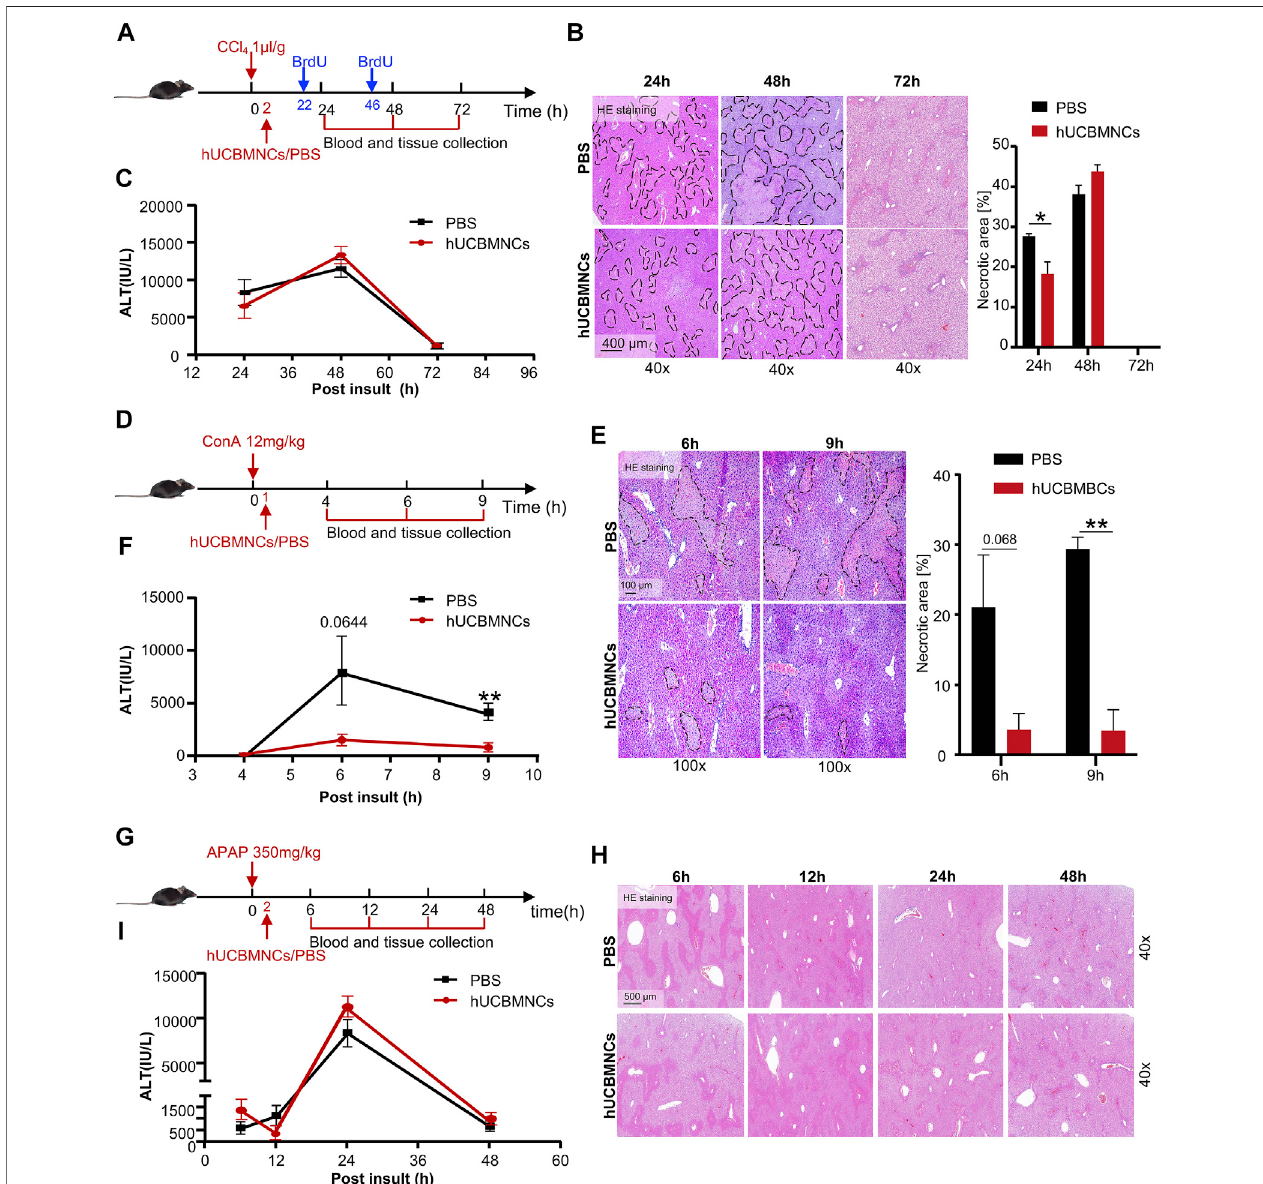
FIGURE2| hUCBMNCstreatmentimprovedCCl 4 /ConA-inducedliverinjurybutdidnotimproveAPAP-inducedliverinjury. (A – C) hUCBMNCstreatmentalleviated livernecrosisinCCl 4 -induced liverinjury(PBS, n =5/time point; hUCBMNCs, n =5/timepoint). (A) Schematicexperimenttimeline ofhUCBMNCs inCCl 4 -induced acute liver injury. (B) H&E staining (40×) and the percentage of necrotic areas of mice liver at 24, 48, and 72 h post CCl 4 injection. Necrotic areas are circled with black dashed lines. (C) Serum ALT levels of mice at 24, 48, and 72 h post CCl 4 insult. The bars represent mean ± SEM. (D – F) hUCBMNCs treatment alleviated liver necrosis in ConA-inducedliverinjury(PBS, n =4/timepoint;hUCBMNCs, n =4/timepoint). (D) SchematicexperimenttimelineofhUCBMNCsinConA-inducedacuteliverinjury. (E) H&E staining (100×) and the percentage ofnecroticareaofmice liver at 6 h, 9 hpost ConA injection. Necrotic areas were circled with black dashed lines. (F) Serum ALT levels of mice at 4, 6, and 9 h post ConA injection. (G – I) hUCBMNCs treatment did not alleviate liver necrosis in APAP-induced liver injury (PBS, n = 4/time point; hUCBMNCs, n =4/timepoint). (G) SchematicexperimenttimelineofhUCBMNCsinAPAP-inducedliverinjury. (H) H&Estaining(40×)ofmiceliverat6,12,24,48 hpost APAP injection. (I) Serum ALT levels of mice at 6, 12, 24, and 48 h post APAP injection.